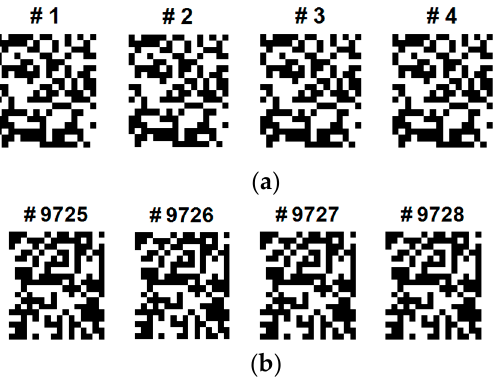
Figure 13. Some selected sample QR training images of data augmentation for the classes of ( a ) left and ( b ) tongue (18 × 16 in C4D2a_4C).